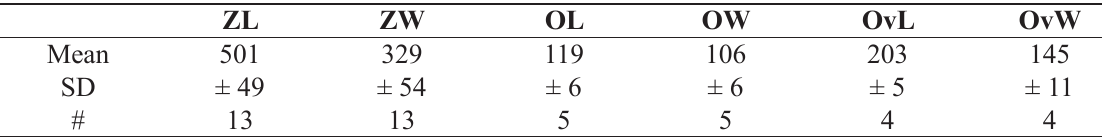
Table 5. Measurements of Atlantisina seinensis gen. et sp.